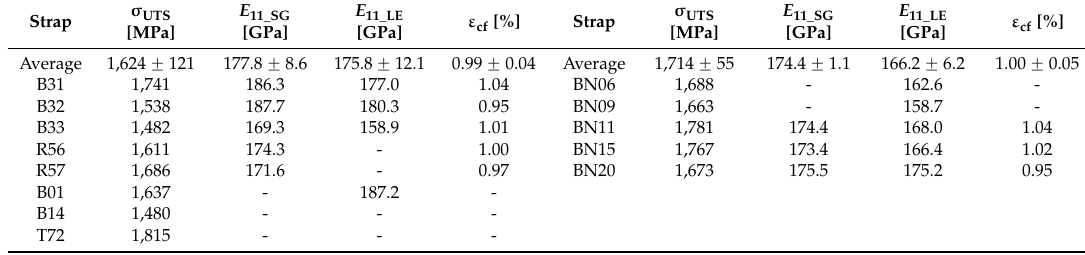
Table 1. Quasi-static tensile strength and stiffness of wide (left) and narrow (right) straps. The fibre parallel elastic modulus E 11 [GPa] was calculated following [17] and was measured with strain gauges ( E 11_SG ) and a linear encoder ( E 11_LE ). The composite strains at failure ε cf [%] were measured with the strain gauges. Wide straps are labelled with B, R or T, depending on the author who manufactured them, followed by the number of the strap. Narrow straps are labelled with BN and the number of the strap.